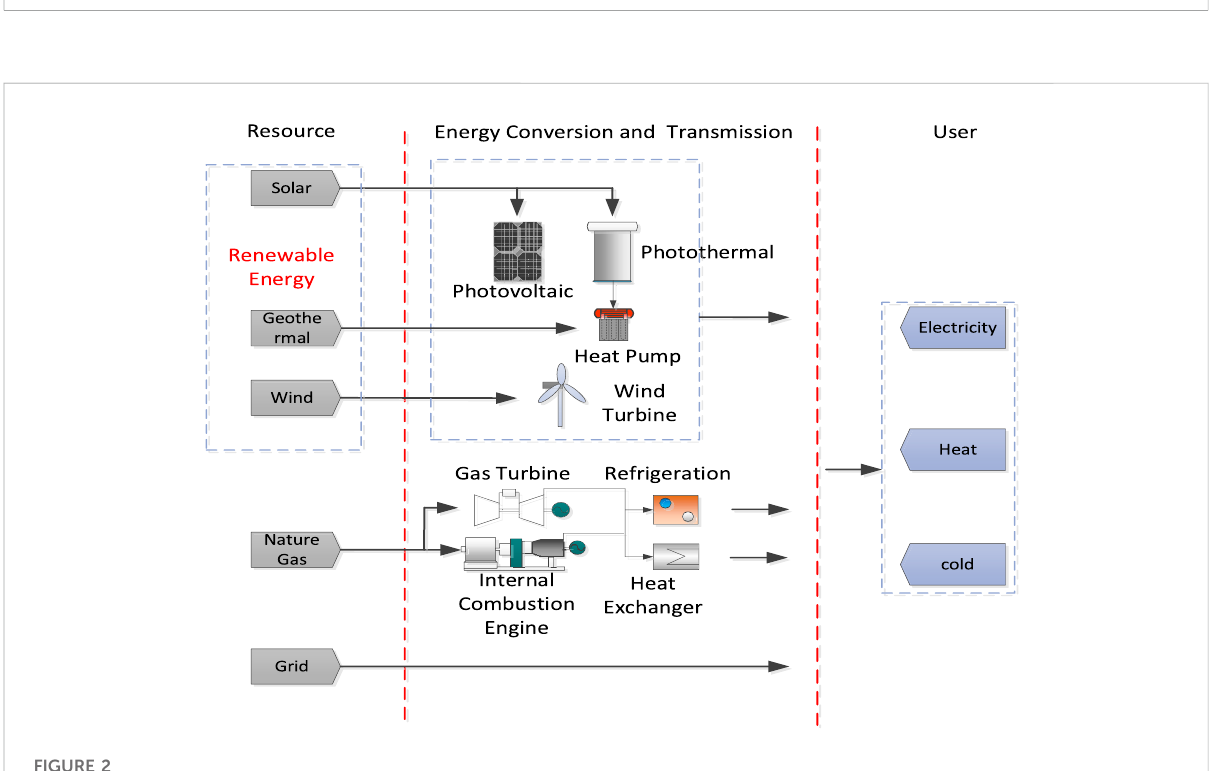
FIGURE 1 Series-integrated multi-energy complementary system.